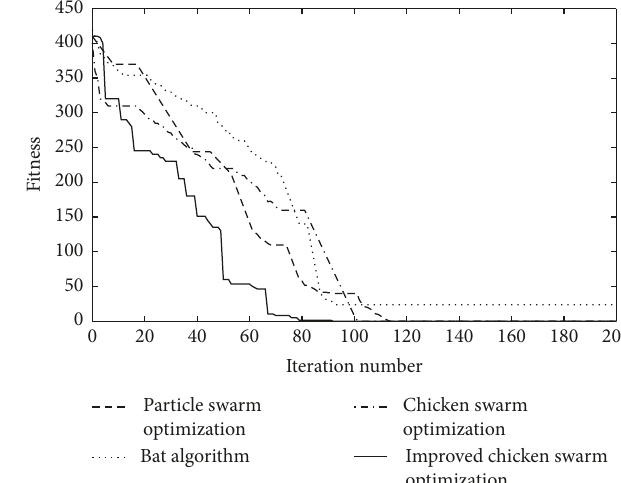
( x ) with 30 dimensions. 1